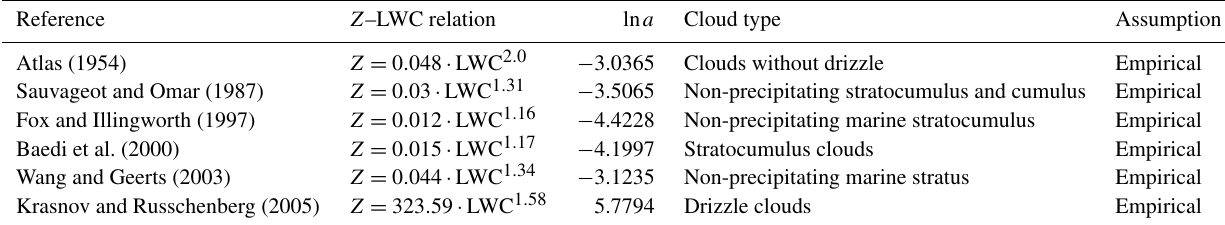
Table 1. Z –LWC relation from the literature.